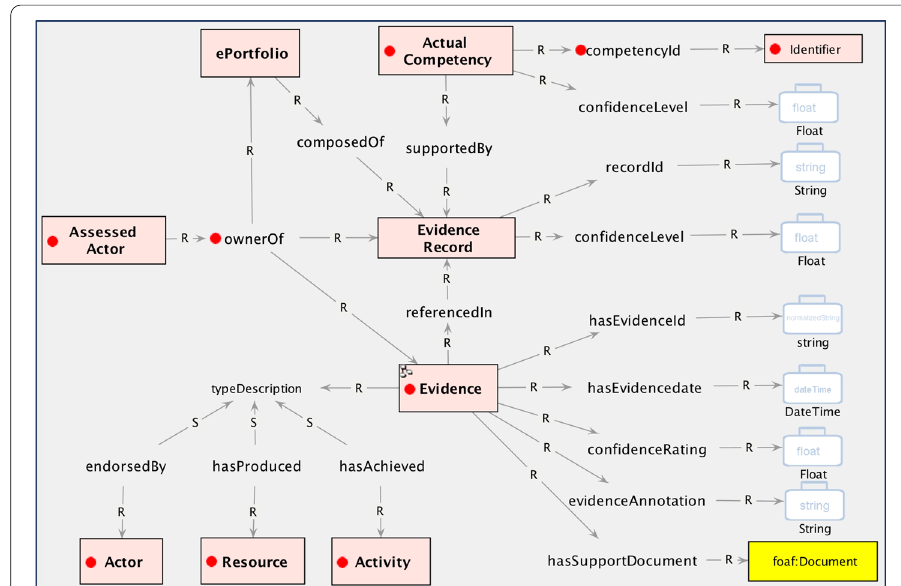
Fig. 6 Evidence sub-model for competency